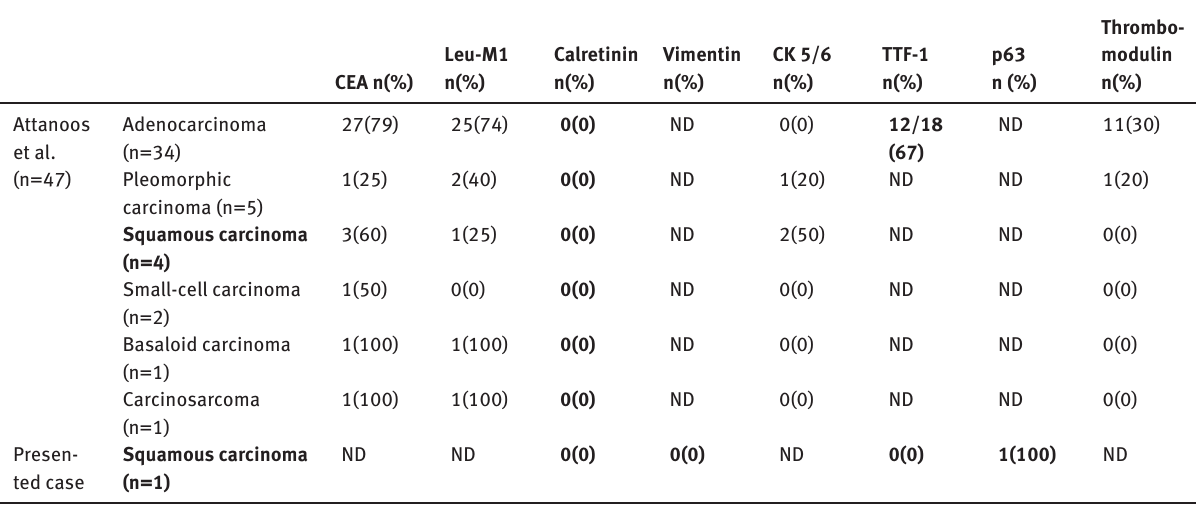
Table 2: Main immunohistochemical markers performed by Attanoos et al. in primary pulmonary carcinomas with diffuse pleurotropic growth and in the presented